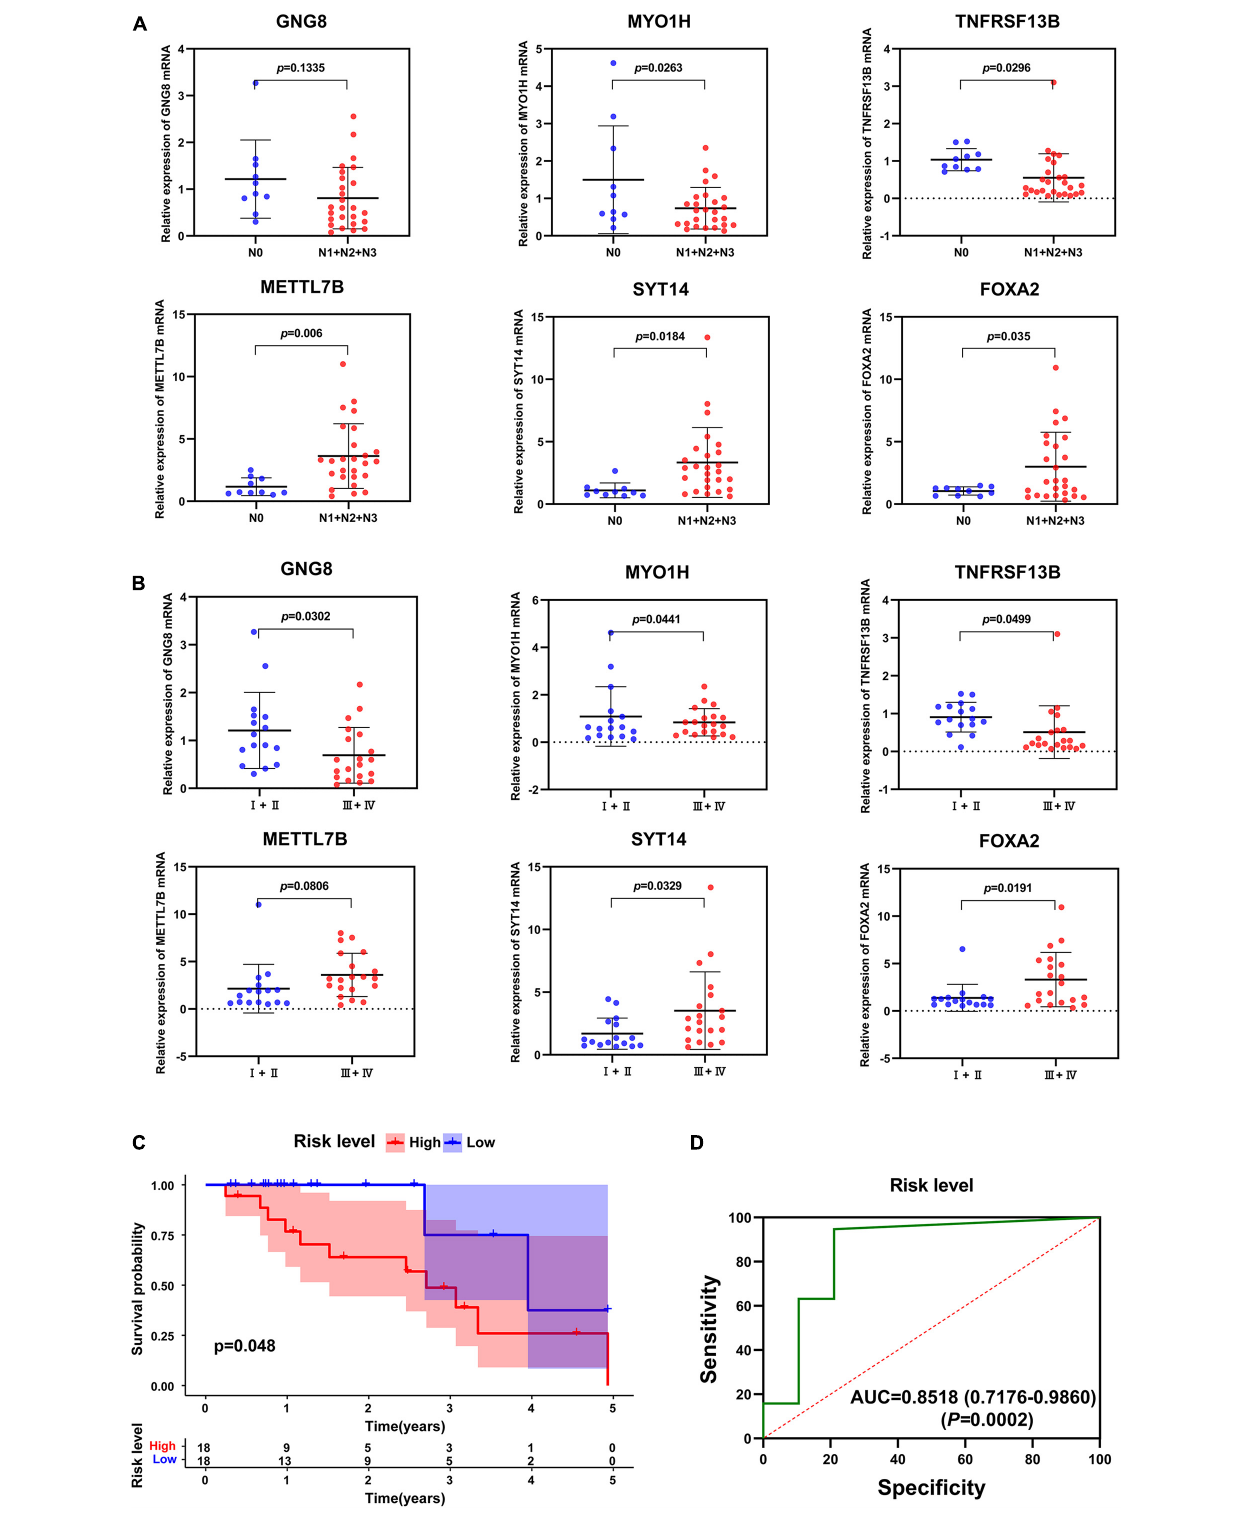
FIGURE 7 | Validation of six-gene prognostic signature by qRT-PCT. (A) The expression of these 6 genes in different N stages. (B) The expression of these 6 genes in different tumor stages. (C) Survival analysis of the prognostic signature in clinical samples. (D) AUC in ROC analysis for the signature at overall survival in clinical